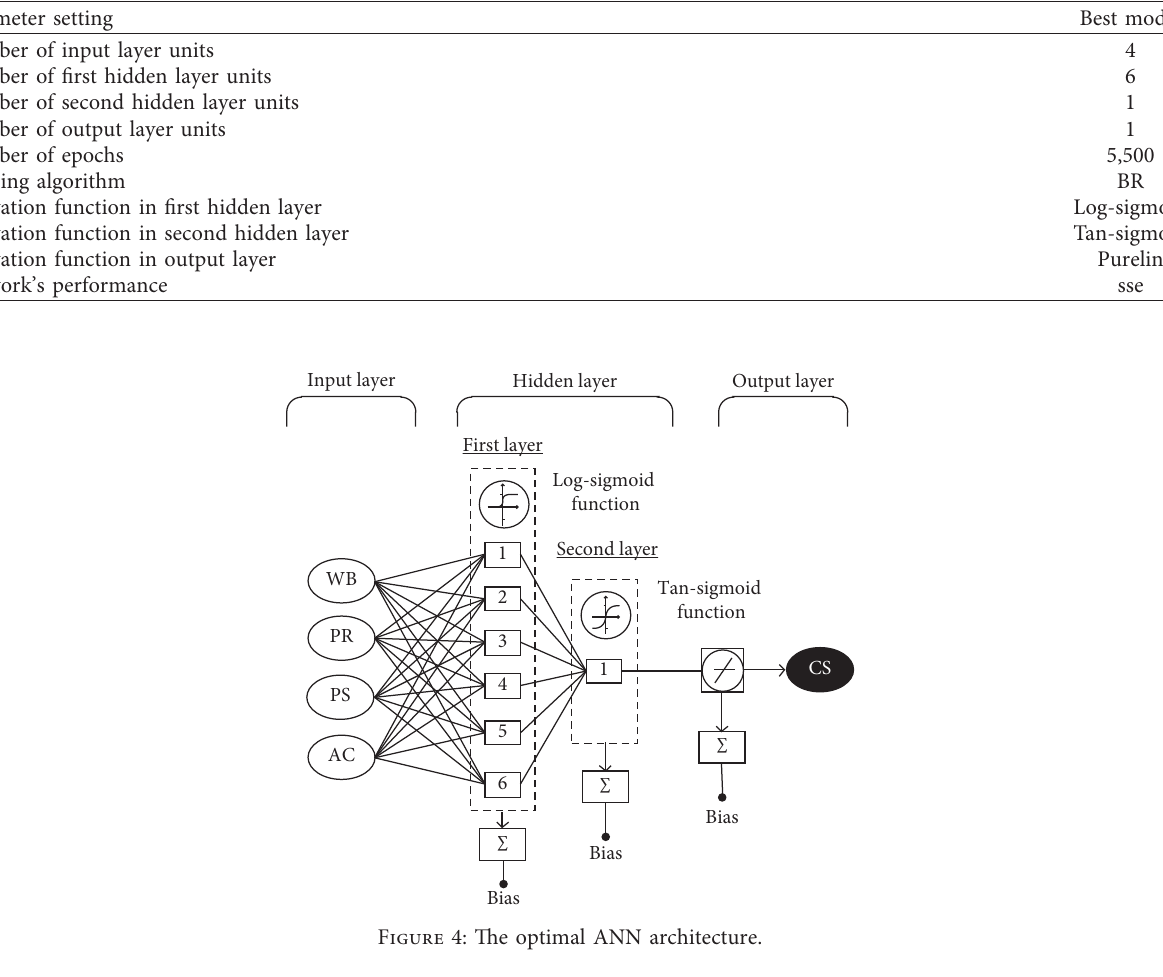
Table 8: The parameter setting used in the optimal ANN models.